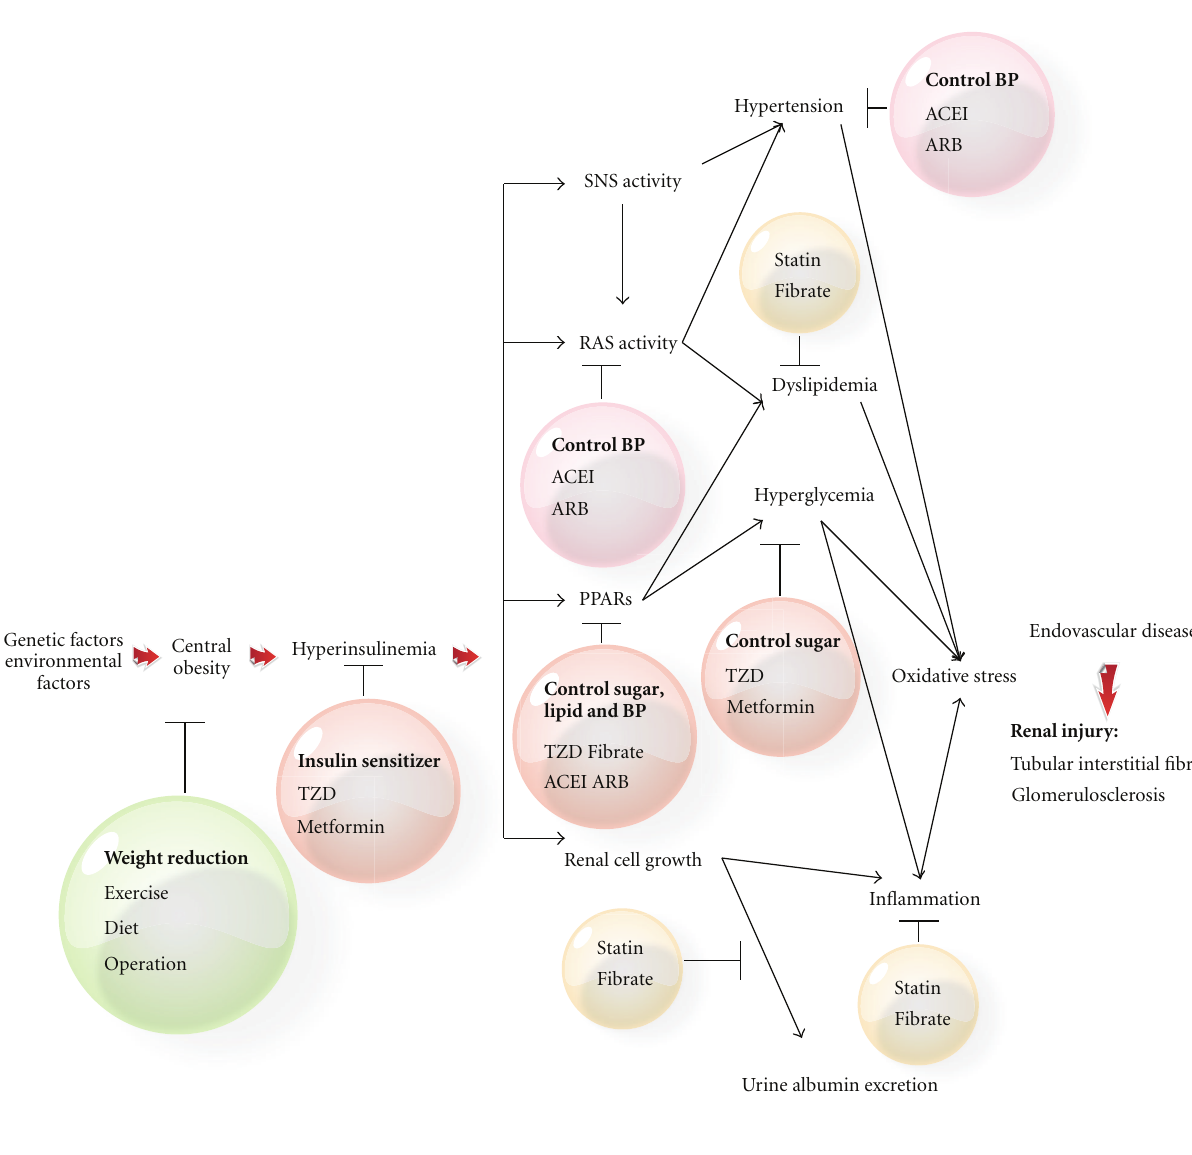
Figure 1: Mechanisms of insulin resistance with the consequent development of renal injury and the target of treatments. SNS: sympathetic nervous system, RAS: renin-angiotensin system, PPAR: peroxisome proliferator-activated receptors, ACEI: angiotensin-converting enzyme inhibitor, ARB: angiotensin II receptor blocker, TZD: thiazolidinediones.